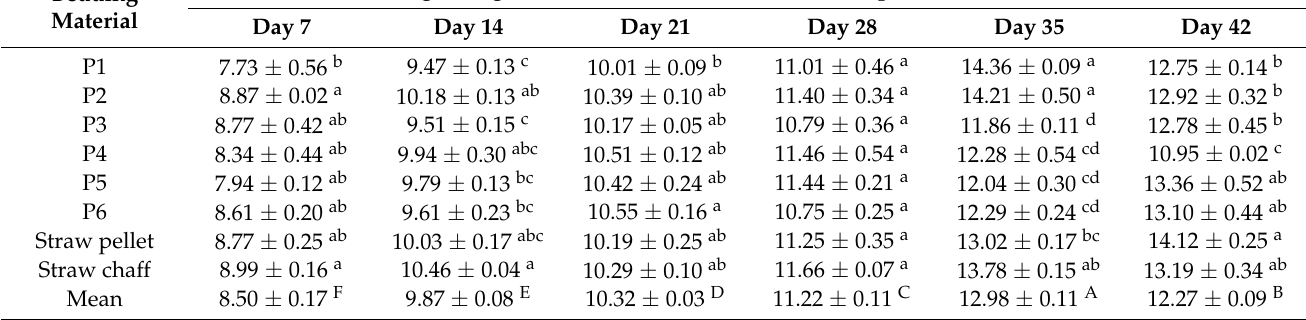
Table 6. Changes in the count of mesophilic aerobic bacteria in the bedding material during use under operational conditions—2nd experimental